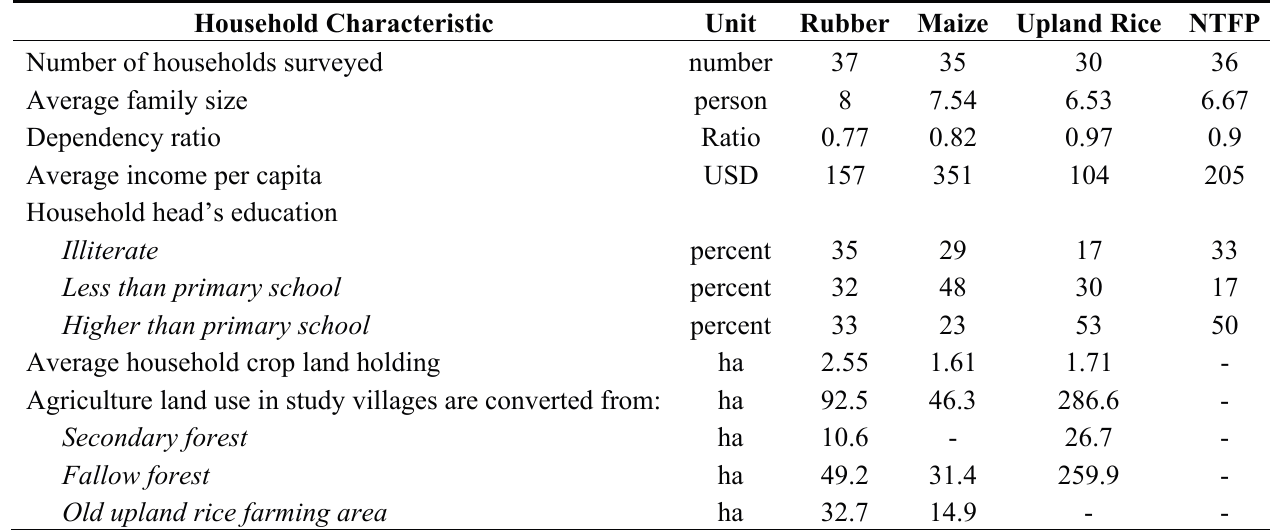
Table 1. Characteristics of Surveyed Households in the Four Research Villages. Source: Field survey data [8]. Unit Rubber Maize Upland Rice